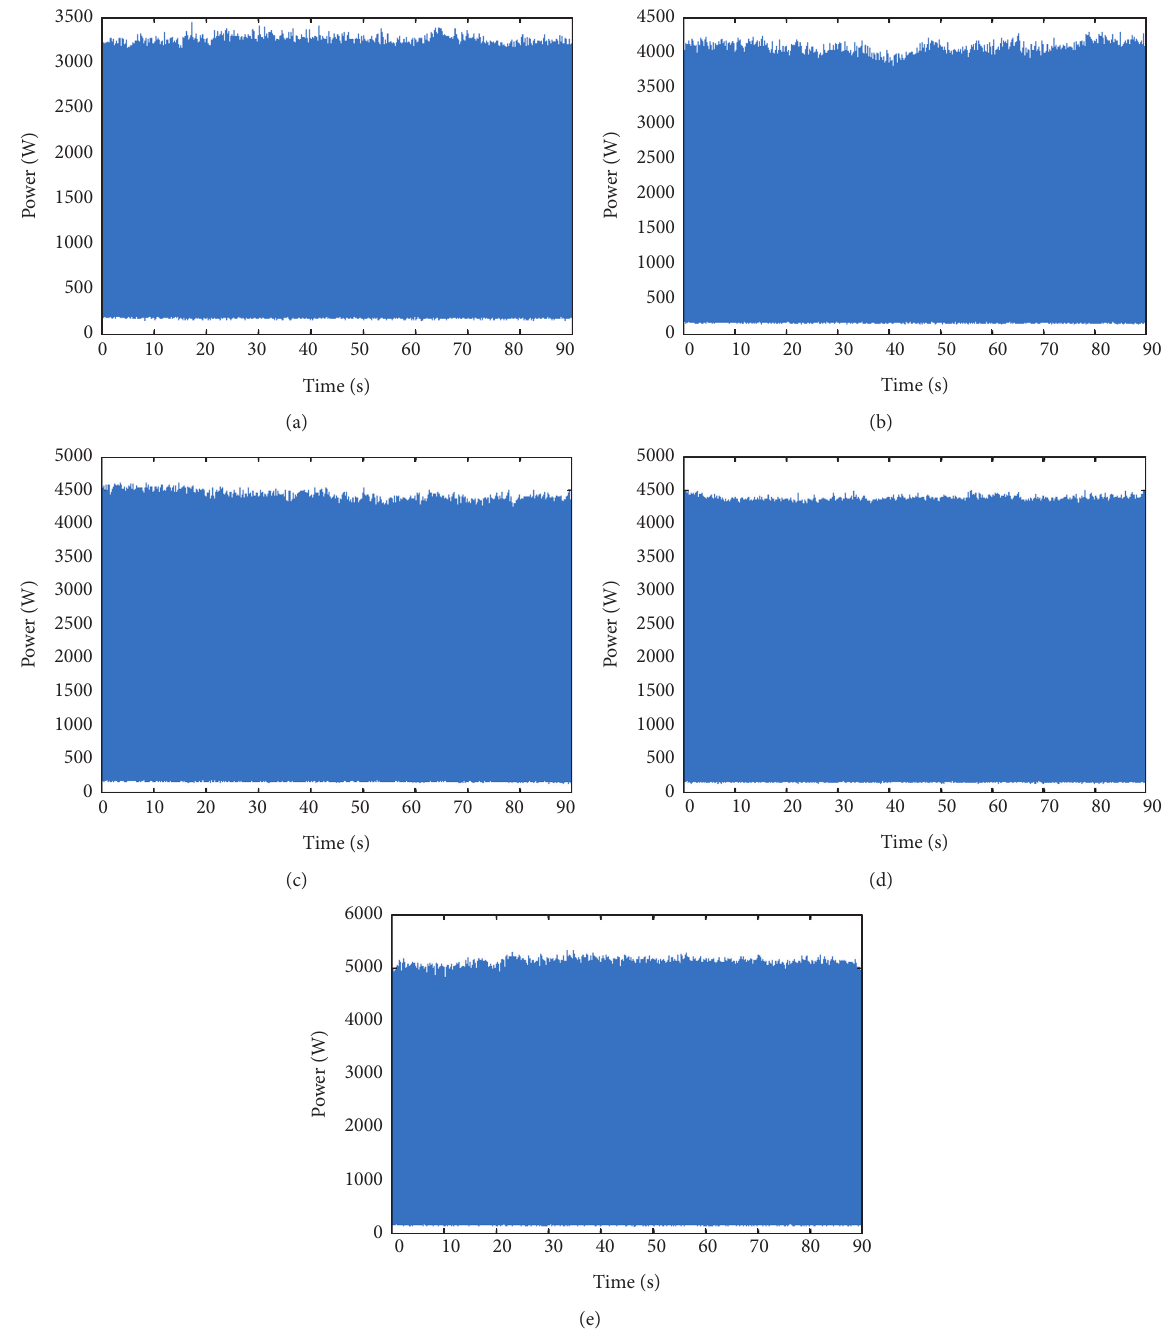
Figure 6: Instantaneous power of 8 mm tool at different wear conditions. (a) 00min. (b) 40min.(c) 60min. (d) 80min. (e)